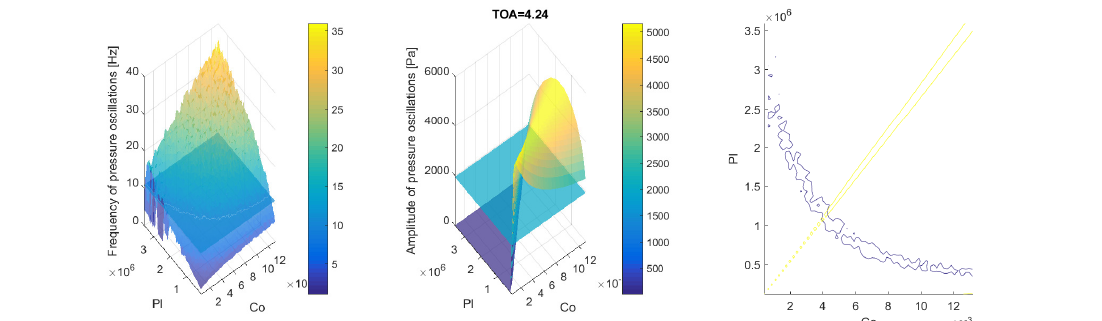
Figure 13. Comparison of experimental and numerical results. Horizontal surfaces on left and central plots correspond to values measured at the test stand, their cutting curves with numerical results are presented on the figure to the